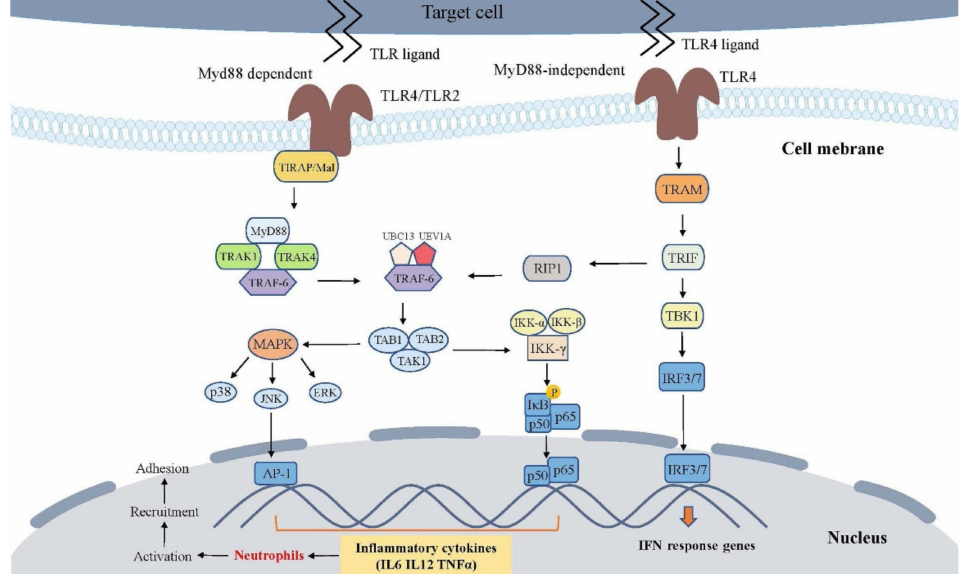
Figure 3. TLRs signaling overview. This figure depicts the endogenous ligands released during xenotransplantation that trigger two of the most important TLR receptors, TLR2 and TLR4, and the MyD88-dependent and MyD88-independent (TRIF-dependent) signaling pathways activated by TLRs. Abbreviation: TLR, toll-like receptor; MyD88, myeloid differentiation primary response protein 88; Mal, MyD88-adapter like; TIRAP, TIR domain-containing adapter; TRAK, TSH-receptor antibody test; TRAM, Trif-related adaptor molecule; TRIF, TIR domain-containing adaptor protein inducing type 1 interferons; TBK1, TANK binding Kinase-1; IRF, interferon regulatory factor; MAPK, mitogen-activated protein kinases; JNK, c-Jun N-terminal kinase; ERK, extracellular signal-regulated kinase; RIP1, Receptor-Interacting Protein 1; TRAF6, tumor necrosis factor-receptor-associated factor- 6; TAK1, TGF- β -activated kinase-1; TAB1, TAK1-Binding Protein-1; TAB2, TAK1-Binding Protein-2; UBC13, ubiquitin-conjugating enzyme-13; UEV1A, ubiquitin-conjugating enzyme E2-variant-1; IKK, IkappaB kinase; AP-1, transcription factor complex-1; interleukin, IL; IFN, interferon; TNF, tumor necrosis